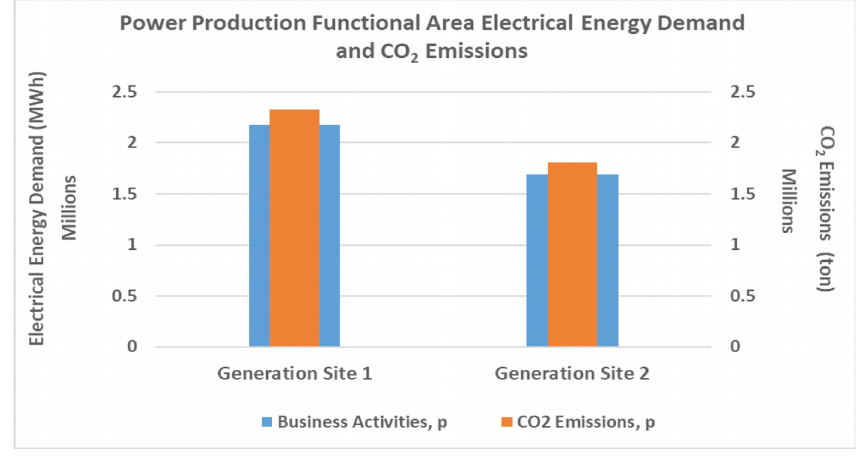
Figure 7. Electrical energy demand of the power production functional areas at each generation